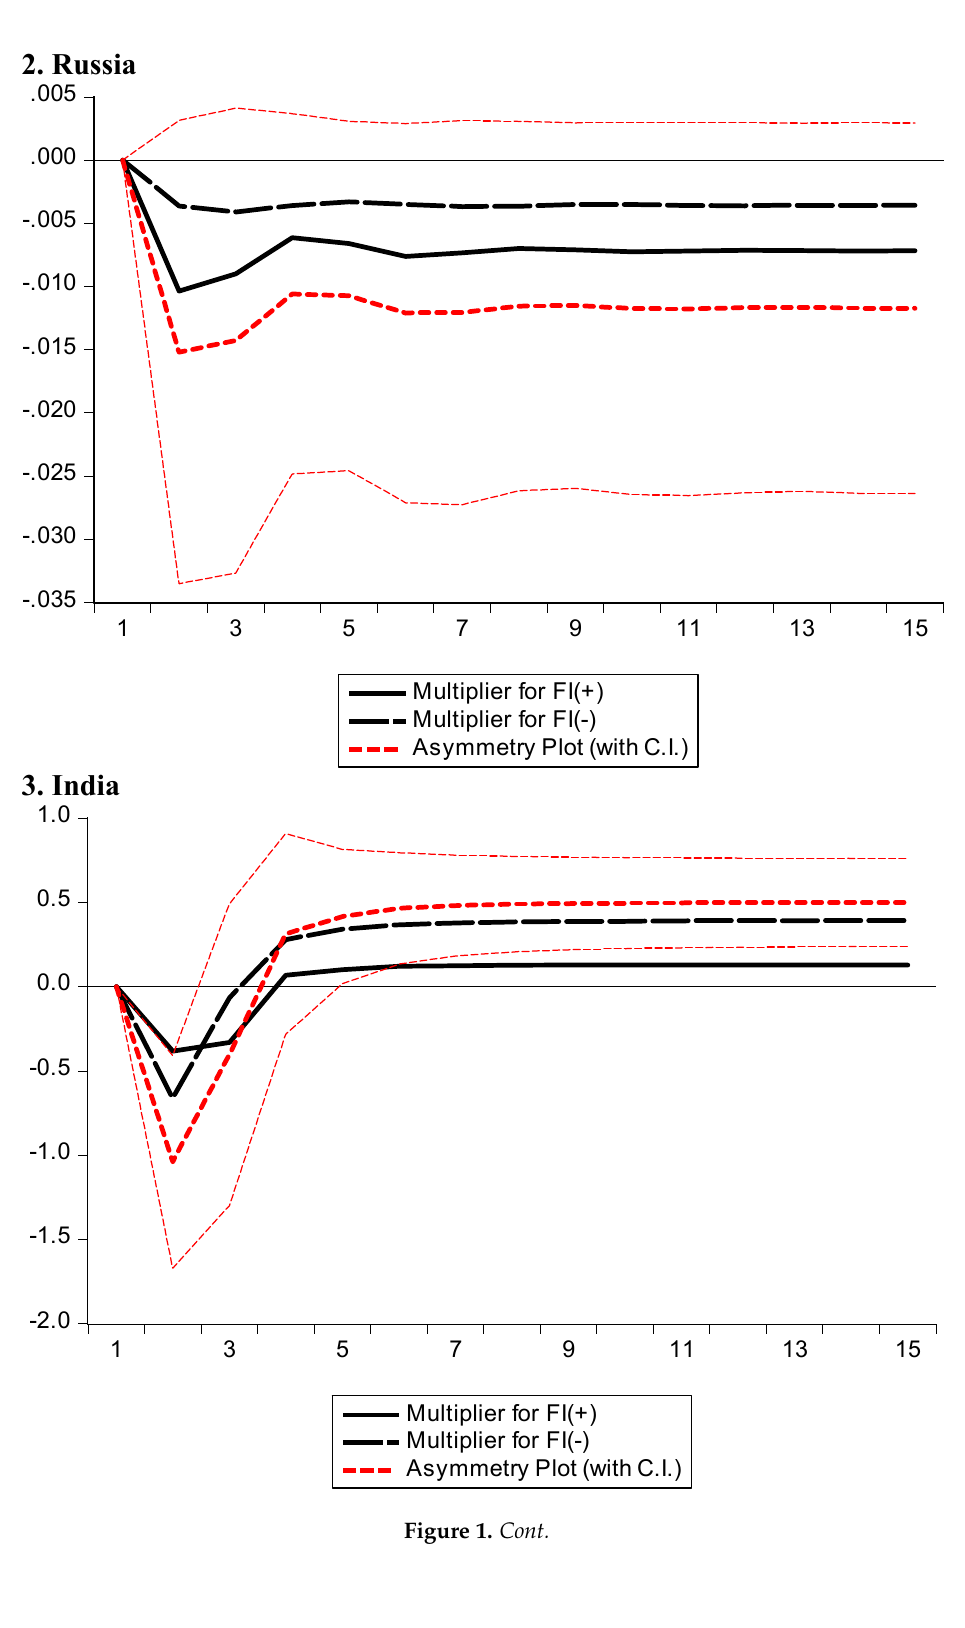
Multiplier for FI(+) Multiplier for FI(-) Asymmetry Plot (with C.I.) Figure 1.